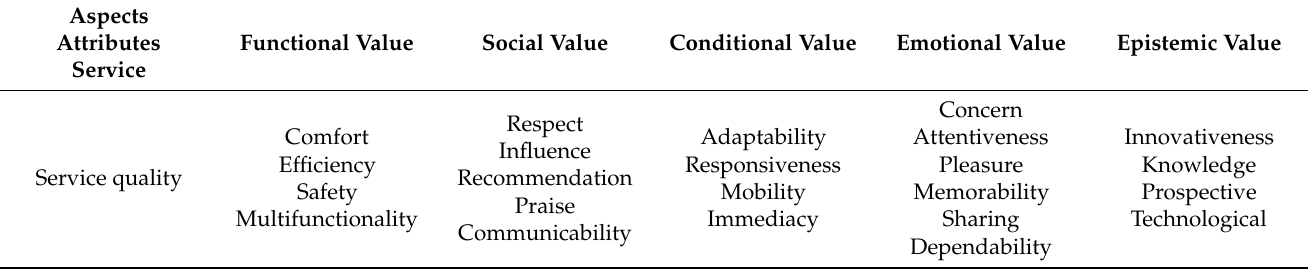
Table 3. Potential CV-SQ attributes classification